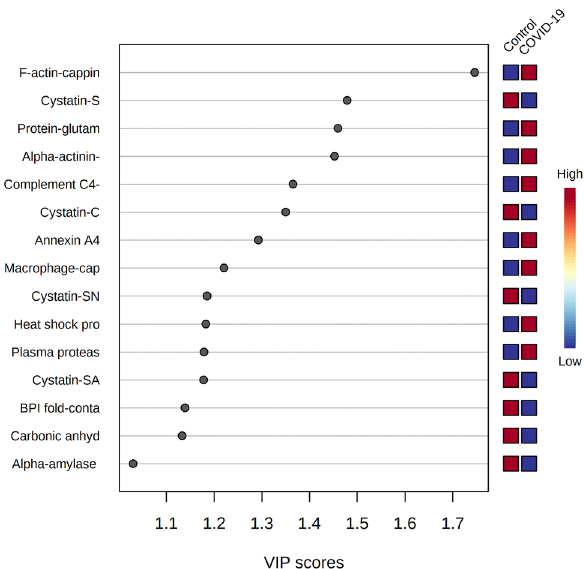
Figure 3. Variable Importance in Projection (VIP) represents the contribution score of the proteins that mostly contribute to the differentiation between COVID-19 and control group. The red and blue boxes on the right indicate the relative amounts of the corresponding protein in each group under study. Source: Metaboanalyst 5.0 (https:// www. metab oanal yst. ca).